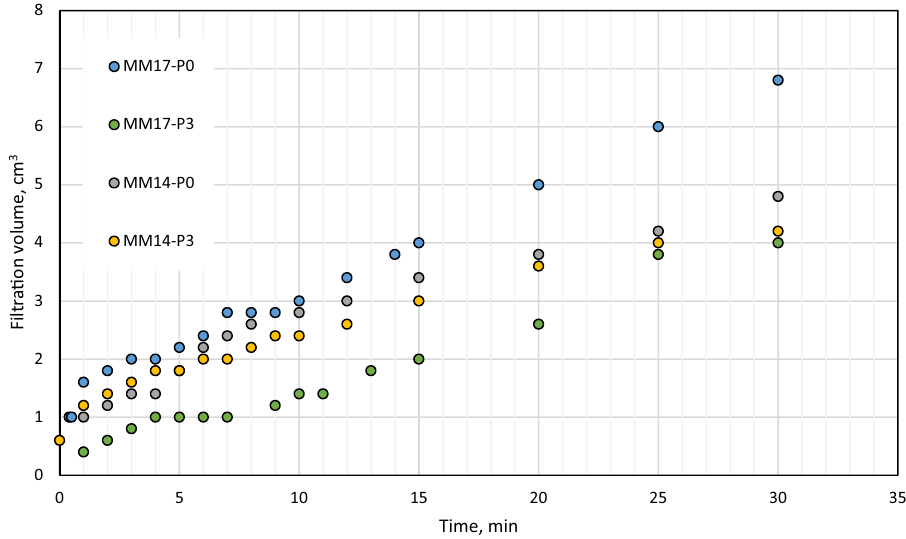
Figure 7. Filtration behavior as function of perlite concentration for mud samples with perlite concentrations equal to 0 and 3 lb/bbl.